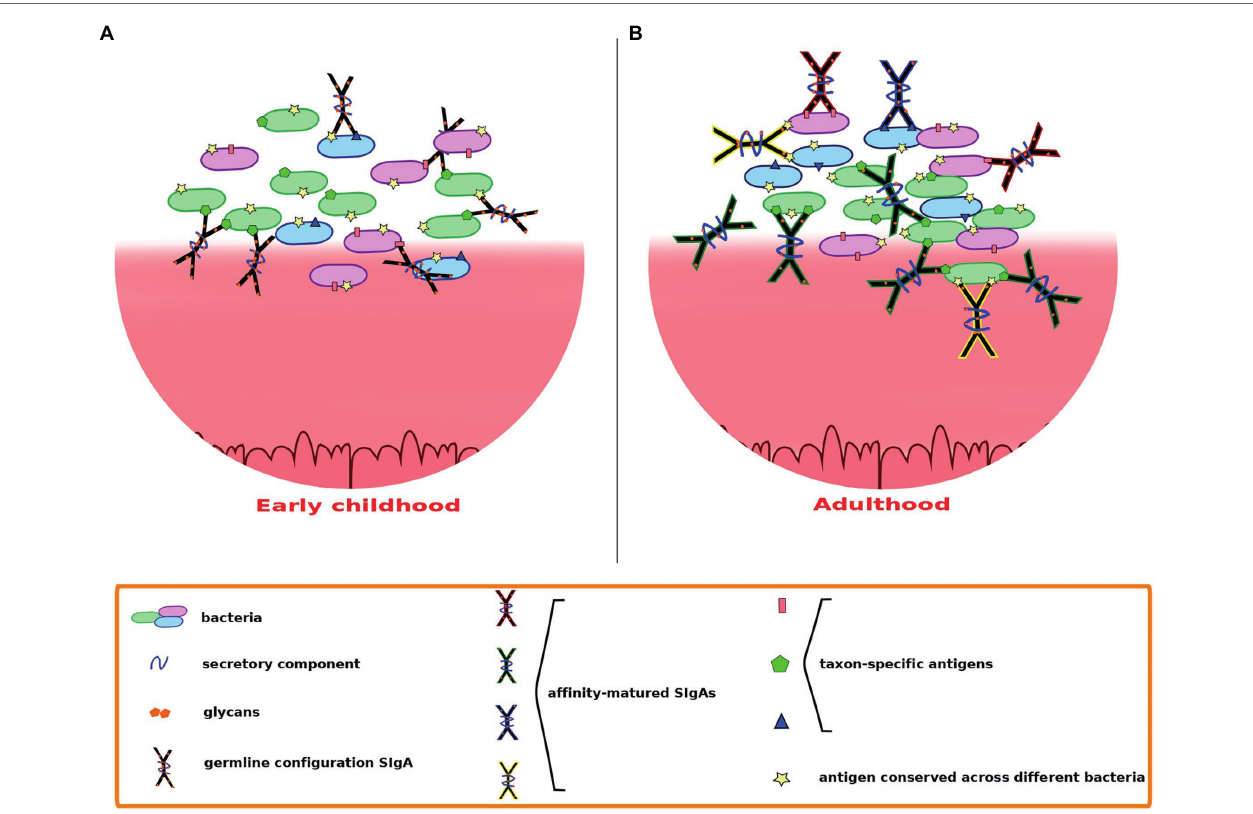
FIGURE 2 | Secretory immunoglobulin A-microbiota interactions may differ depending on the host’s life stage. (A) In early childhood, possibly up to around 3 years of age, polyreactive SIgAs in germline configuration may dominate, cross-reacting through low to moderate affinity canonical binding. (B) In adults, somatic mutations undergone throughout life confer to SIgA the ability to recognize specific epitopes with high affinity, providing better recognition and containment of microbiota members that may act as opportunistic pathogens. Cross-species reactivity may continue through binding of conserved epitopes shared across